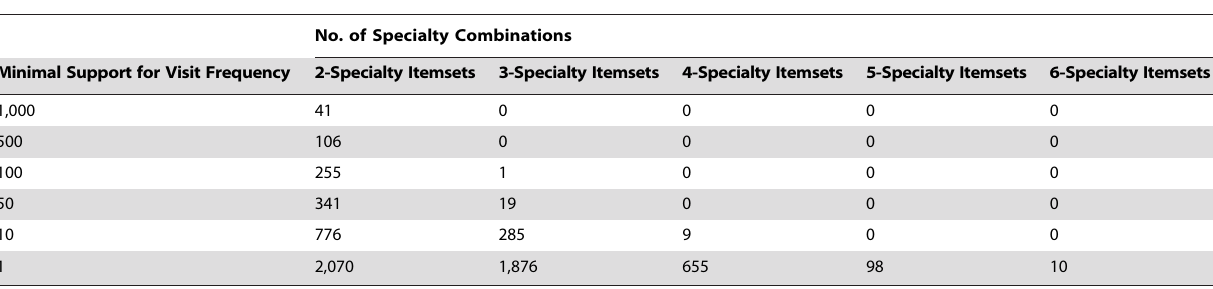
Table 2. Numbers of specialty combinations (itemsets) a for one-stop visits b at different minimal supports for visit frequency of an itemset, stratified by number of specialties in an